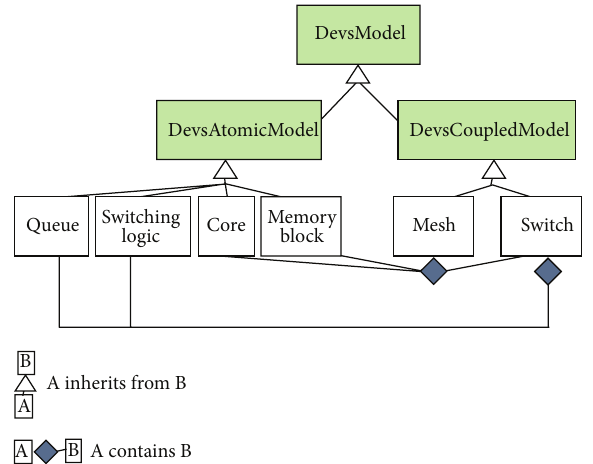
Figure 8: Class diagram illustrating the DEVS-to-DEUS mapping for the proposed NoC example.